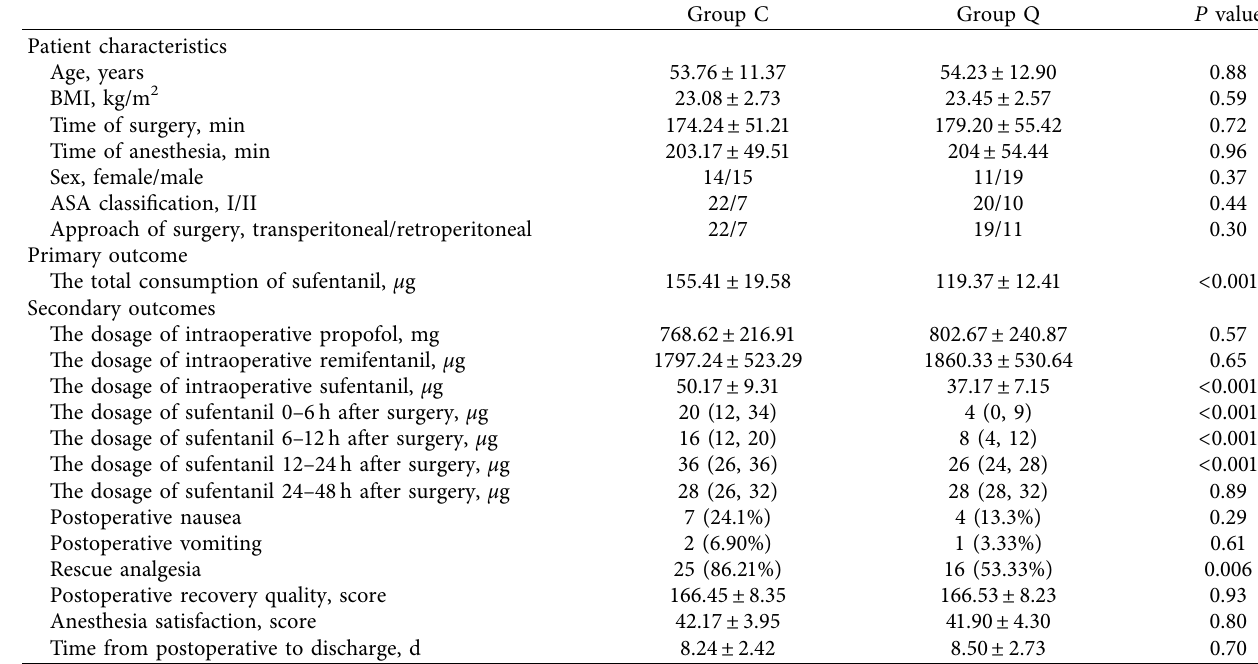
Table 1: Patient’s characteristics, primary outcome, and secondary outcomes.